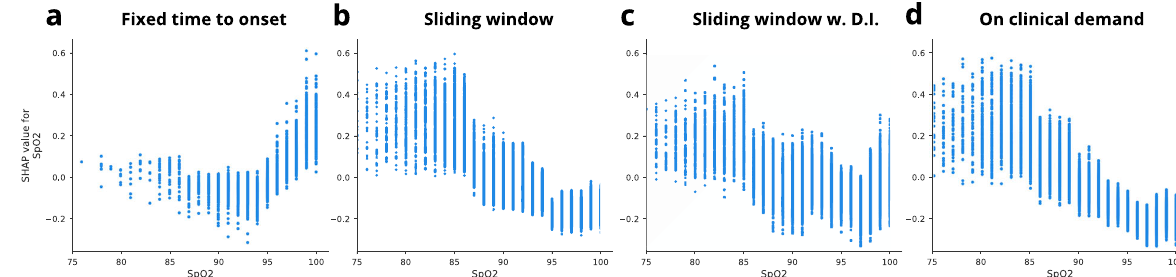
Fig. 5 SHAP dependence plot SpO 2 . Fixed time to onset is shown in ( a ), sliding window in ( b ), sliding window with dynamic inclusion in ( c ), and on clinical demand in ( d